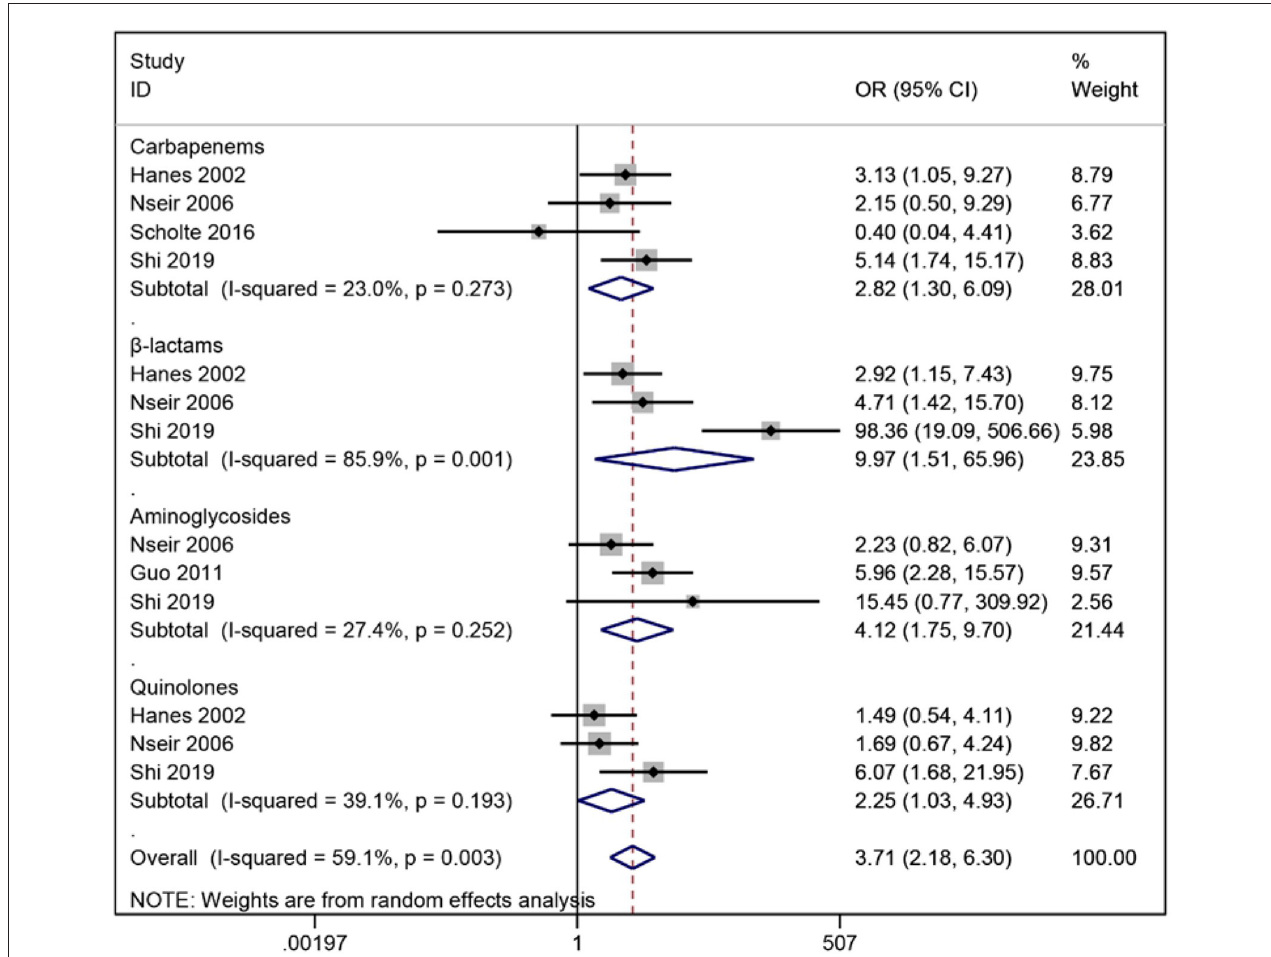
( Figure 2 ). Severity of illness is also an important factor